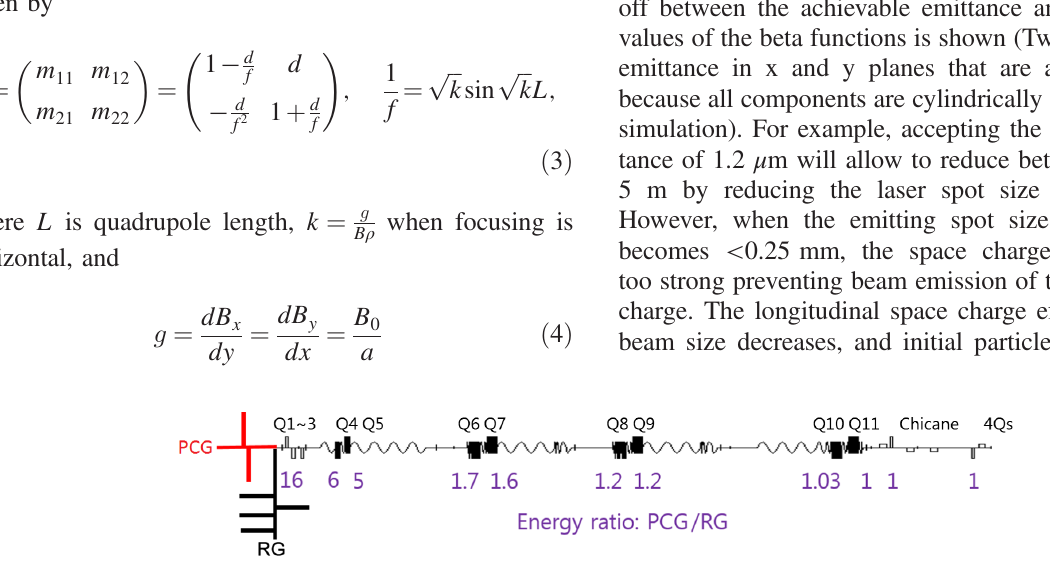
FIG. 5. Beam line layout from each gun to the matching point downstream of the chicane. Energy ration between PCG and RG is also shown in the figure.